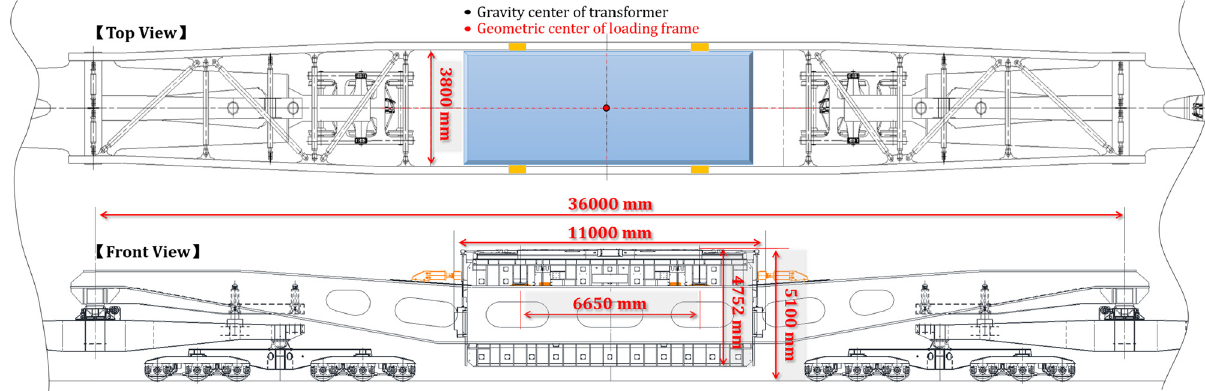
Figure 11: The frame structure and loading dimension for transformer.